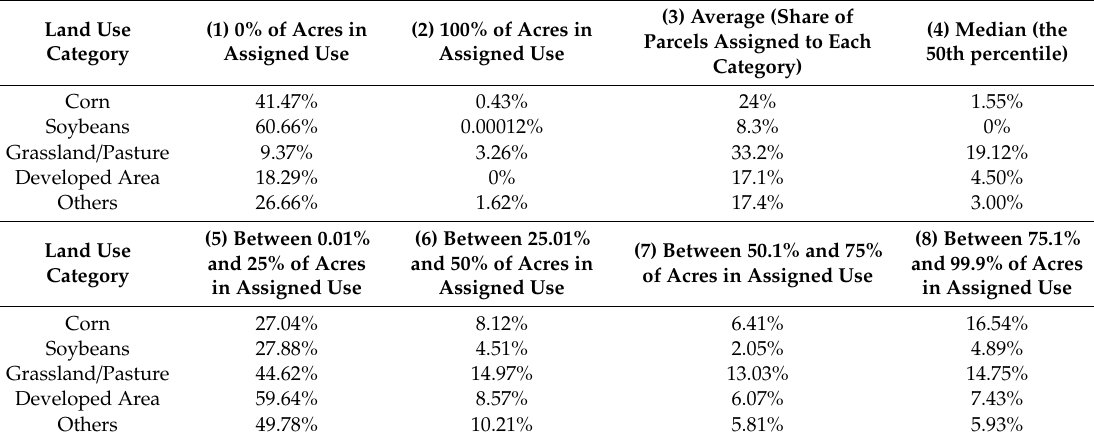
Table 2. Assigned land-use in